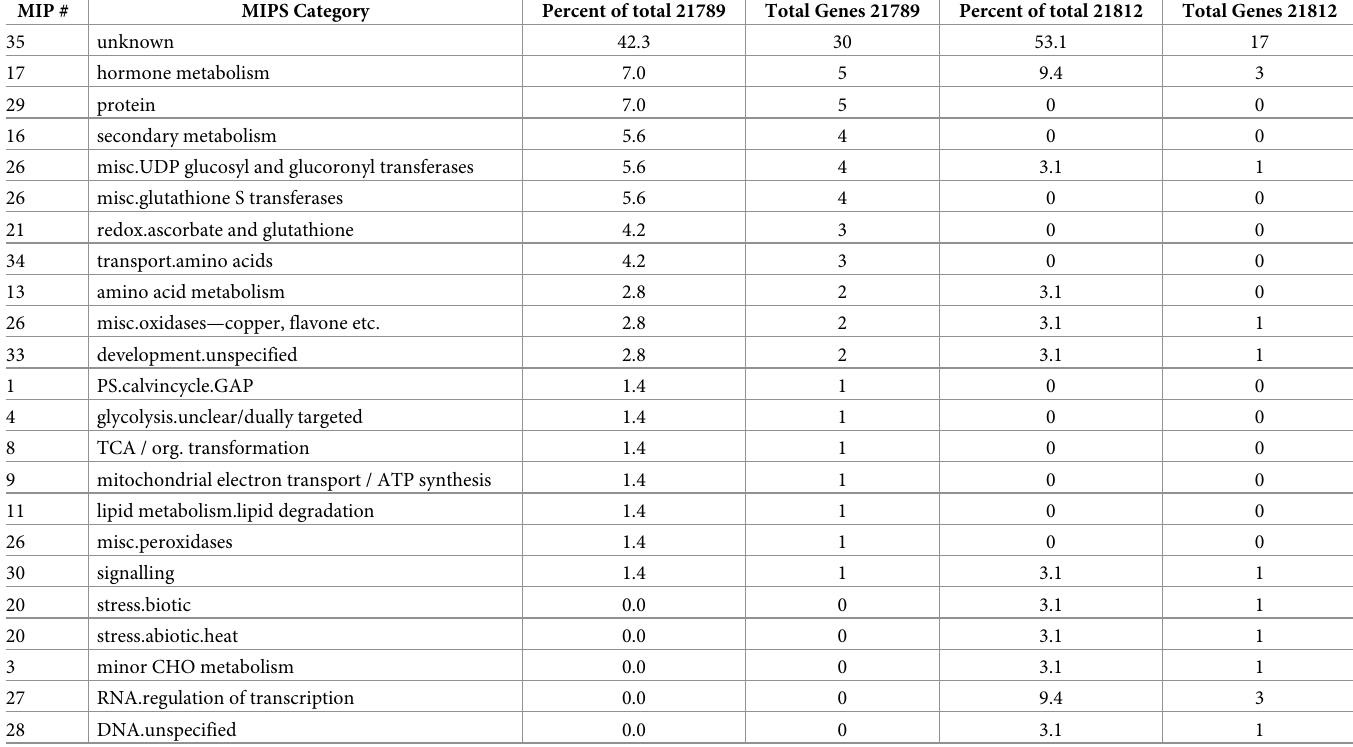
Table 6. Distribution in MIPS categories of differentially expressed genes in Ames 21789 and Ames 21812 under weed stress in